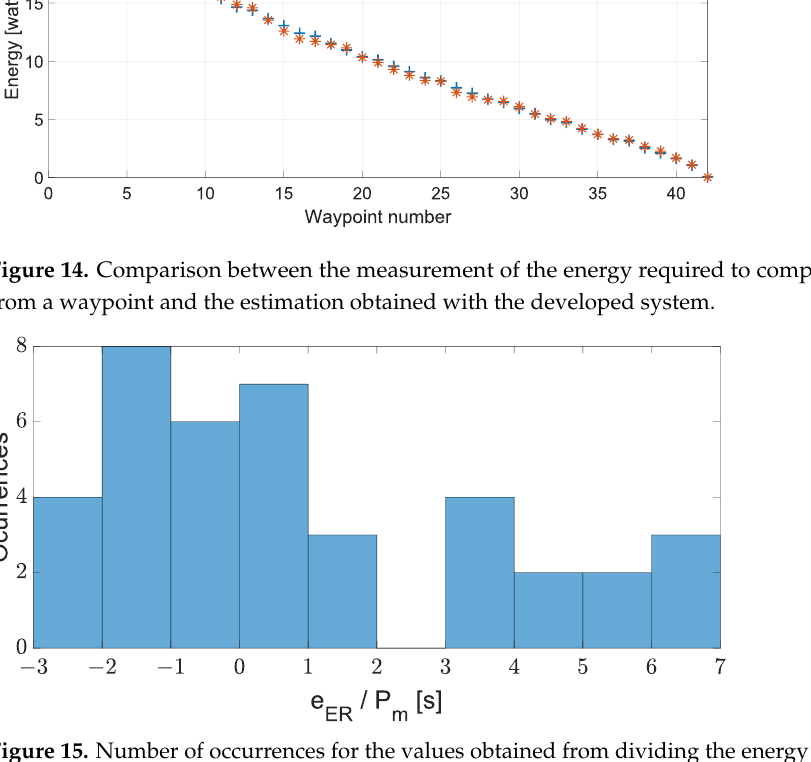
Figure 15. Number of occurrences for the values obtained from dividing the energy estimation error by the average required power in the mission. This value can be interpreted in terms of flight